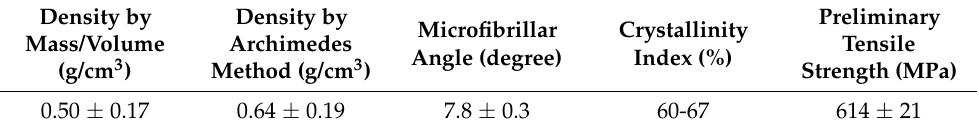
Table 1. Properties reported for guaruman fiber